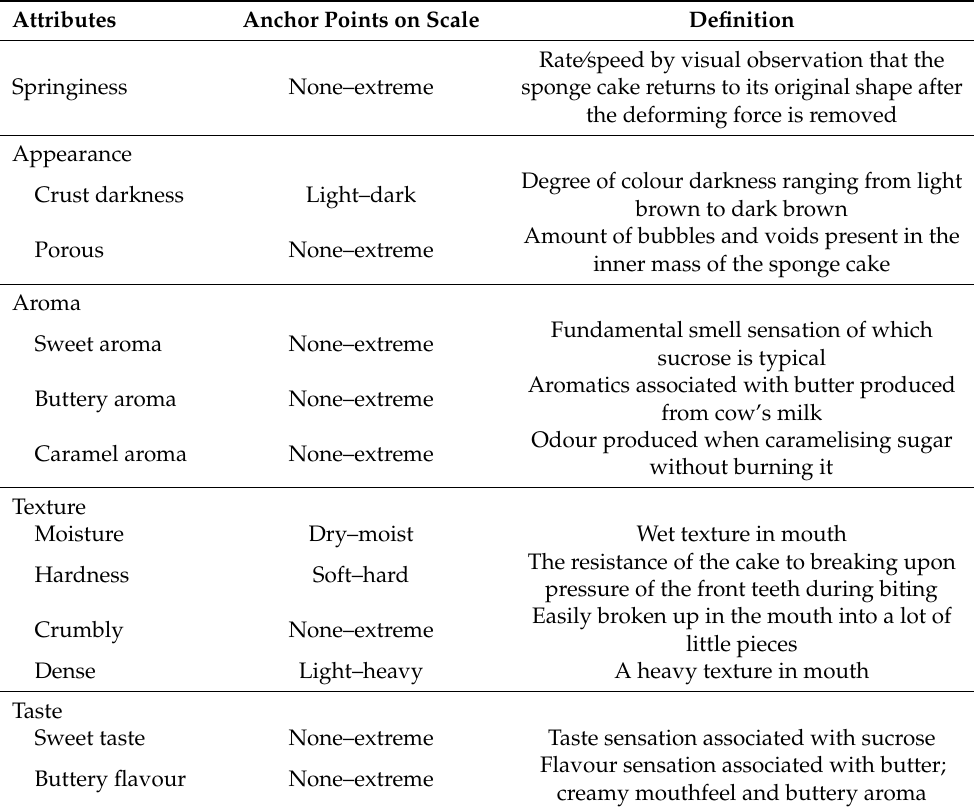
Table 2. Consensus list of sensory descriptors and definitions selected by panel and used in ranking descriptive analysis of sponge